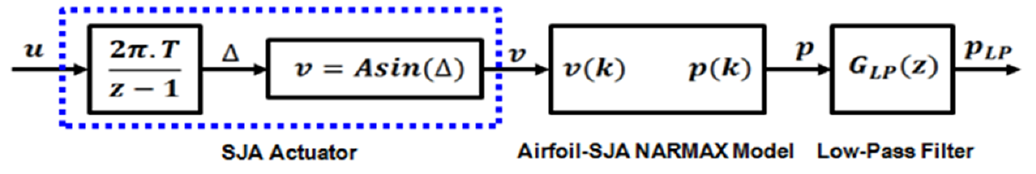
Figure 13. Schematic of an open-loop control system.